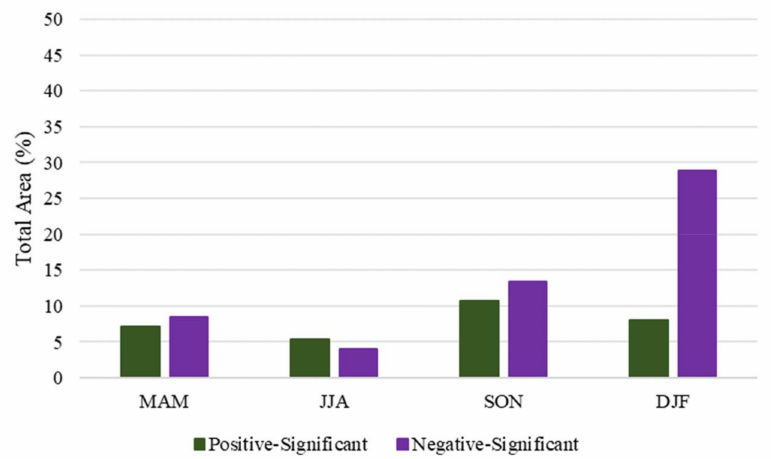
Figure 3. The directional persistence outcomes as a percentage of the total area analyzed in each season: March–May (MAM), June–August (JJA), September–November (SON), and December– February